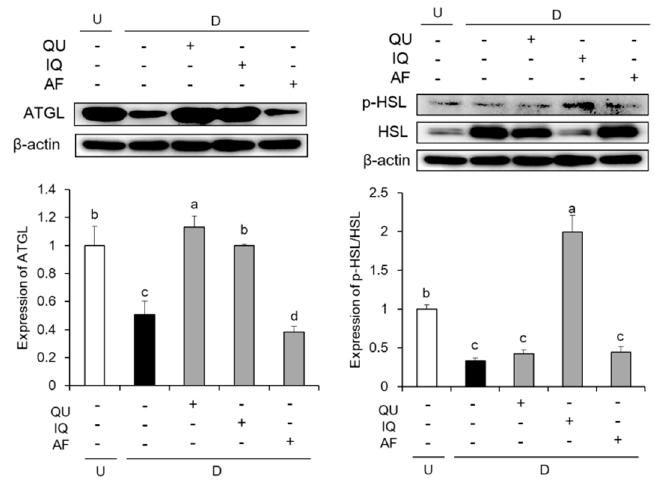
Figure 6. Effects of flavonoids from Acer okamotoanum (10 µg/mL) on lipolysis associated protein expressions in differentiated 3T3-L1 cells. Adipocyte differentiation was induced by treatment with MDI media in the absence or presence of flavonoids from A. okamotoanum during 2 days. The MDI media was then replaced with insulin media, and it was changed four times for every 2 days. Data are expressed as the mean ± standard deviation. a–d Means with different letters indicate significant differences ( P < 0.05) by Duncan’s multiple range test. β -actin was used as a loading control. Relative expression levels were normalized to the β -actin levels and the normal group. Normal group indicates non-differentiated cells, whereas control group indicates the differentiated cells by treatment of MDI media. U: Undifferentiation; D: Differentiation; QU: Quercitrin; IQ: Isoquercitrin; AF: Afzelin.